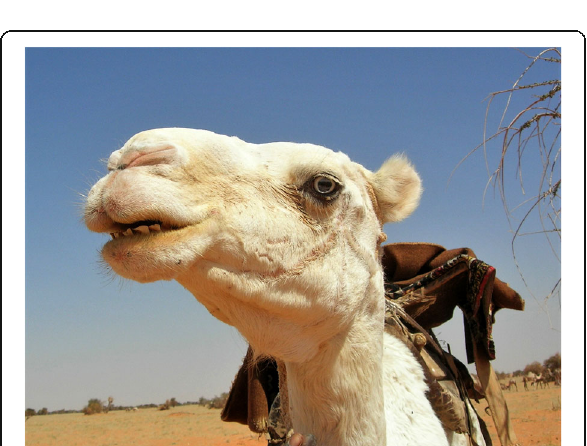
Figure 6 Riding camel of Western Sahara with solid coat and blue eyes (D. Rossi)